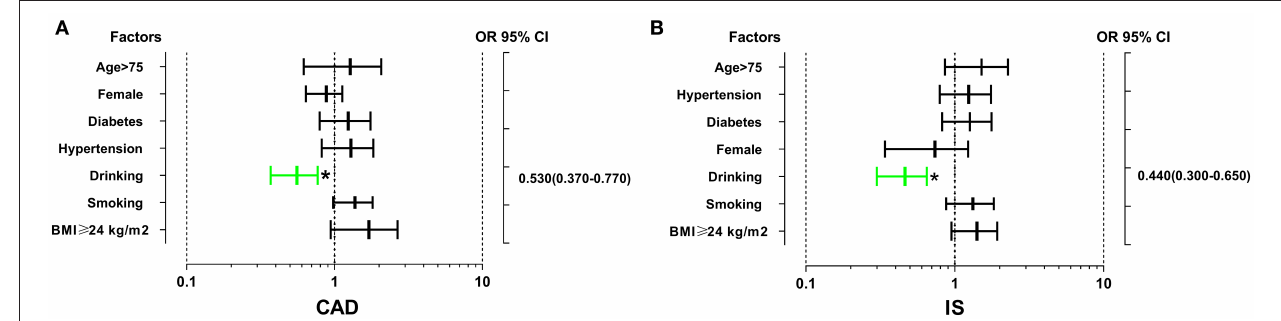
FIGURE 1 | The interactions of the SLC22A3 rs539298 SNP and diabetes, drinking, hypertension, smoking, age, sex, and BMI on the risk of CAD and IS. The rs539298AG/GG genotypes interacted with alcohol consumption to decrease the risk of CAD (A) (OR = 0.53, 95% CI = 0.37–0.77) and IS ( B) (OR = 0.44, 95% CI = 0.30–0.65). * P <